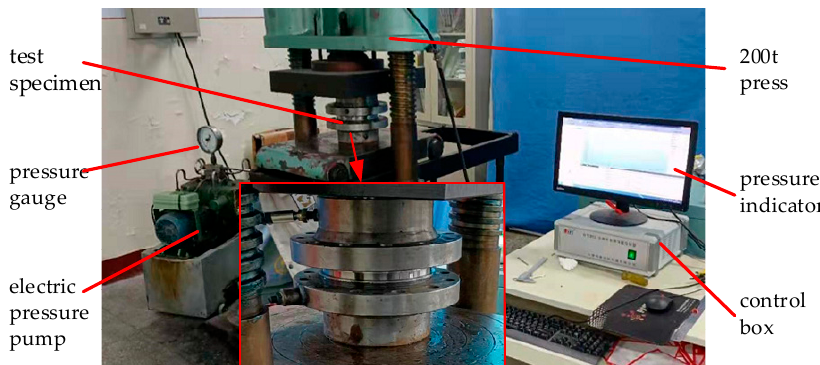
Figure 11. The inner cavity and the interlayer cavity sealing test equipment.